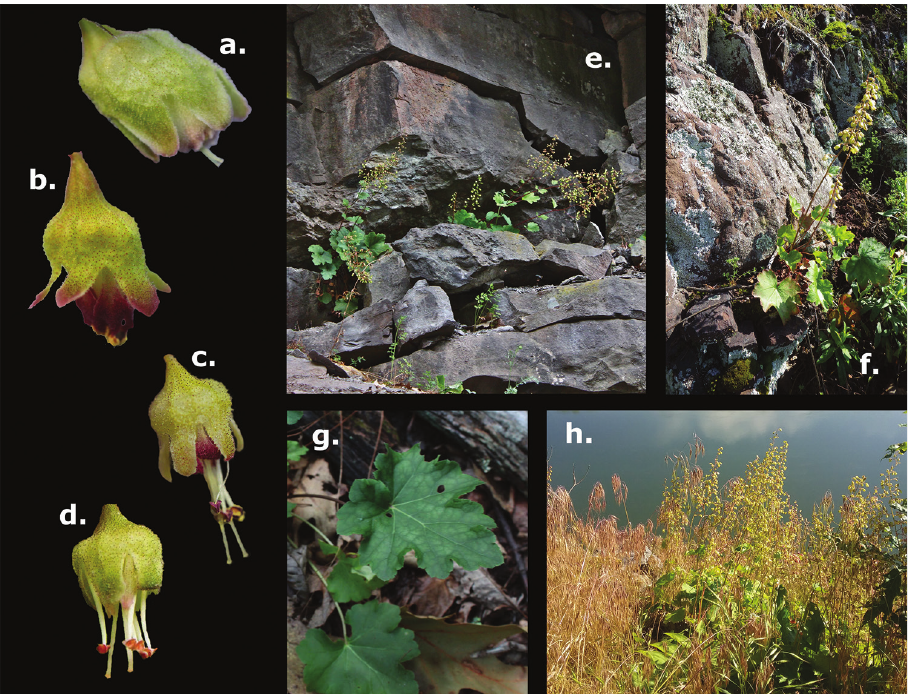
Figure 2. Images a–d Flowers of four Heuchera taxa overlapping in range in PA, WV, and VA. Flowers are shown at the original angle on the inflorescence; with the exception of the wild accession in ( d ), all flowers were obtained under common greenhouse conditions after at least a year of cultivation a H.